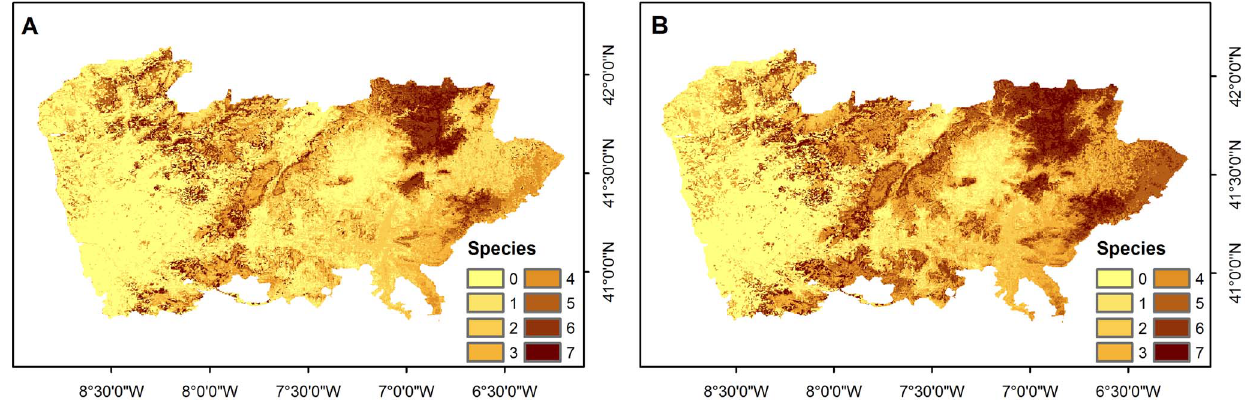
Figure 3. Current predicted species richness for full model (A) and climatic model (B). Current predicted species richness for full model (A) and climatic model (B).